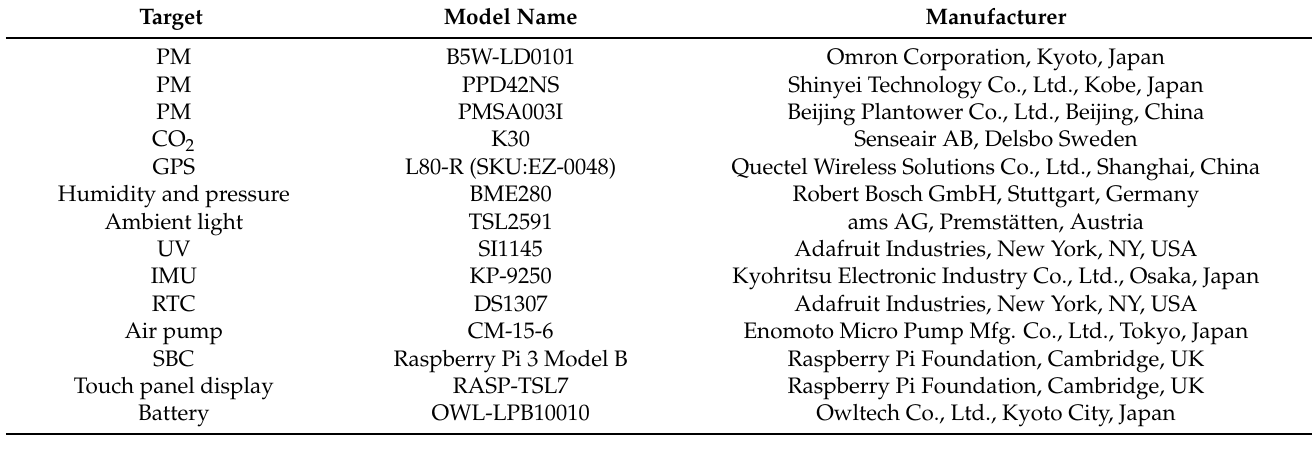
Table 1. Devices and sensors for developing MSS.